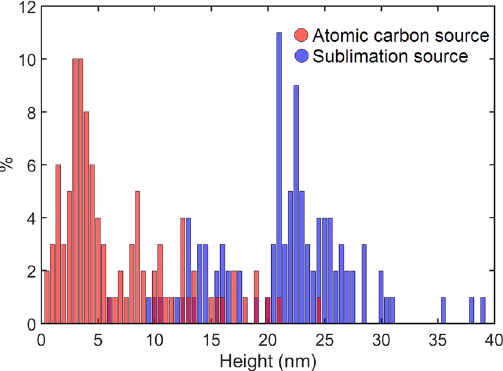
Figure 3. Height distribution of bulk carbon deposits on the hBN surface for the samples shown in Fig. 2 grown using the atomic carbon source (red) and the sublimation carbon source (blue).